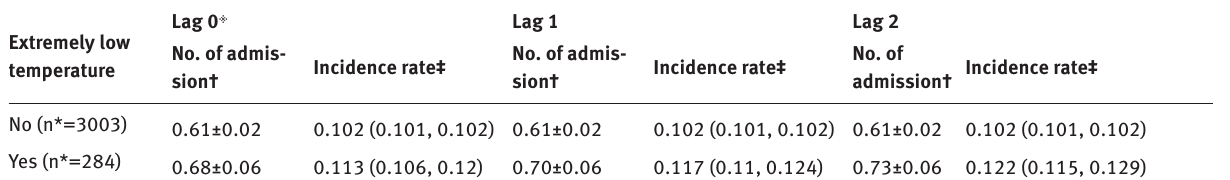
Table 2: Extremely low temperature correlates with acute myocardial infarction (AMI) admission (n=2033 patients) Lag 0 ※ Lag 1 Extremely low temperature